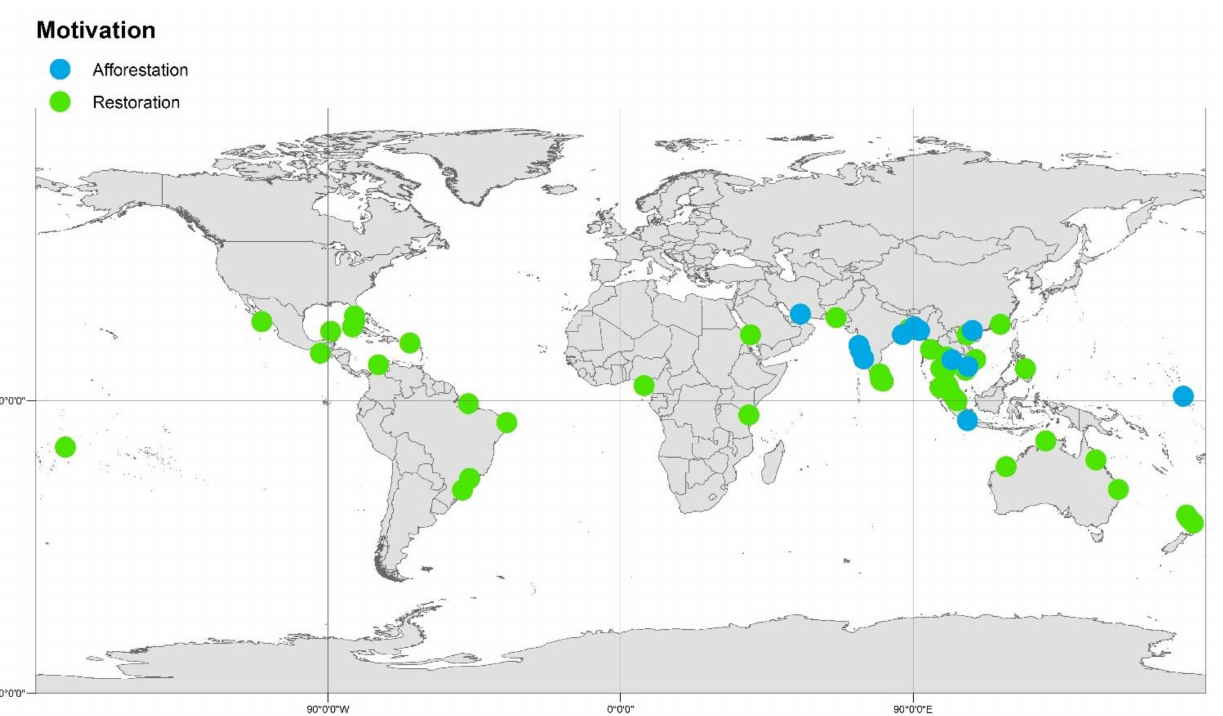
Figure 1. Map of mangrove planting projects included in this current study, with colors indicating the primary motivation for